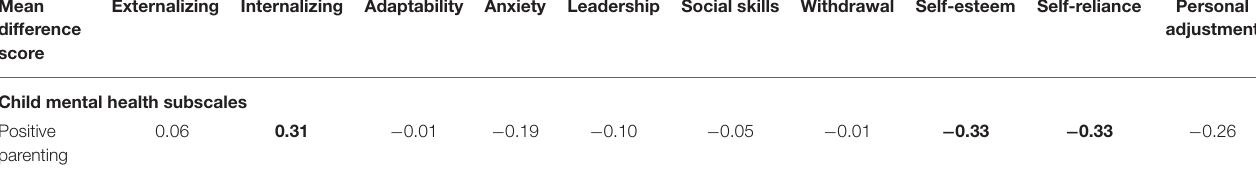
TABLE 3 | Bivariate correlations between mean positive parenting difference scores and child mental health outcomes. Mean difference